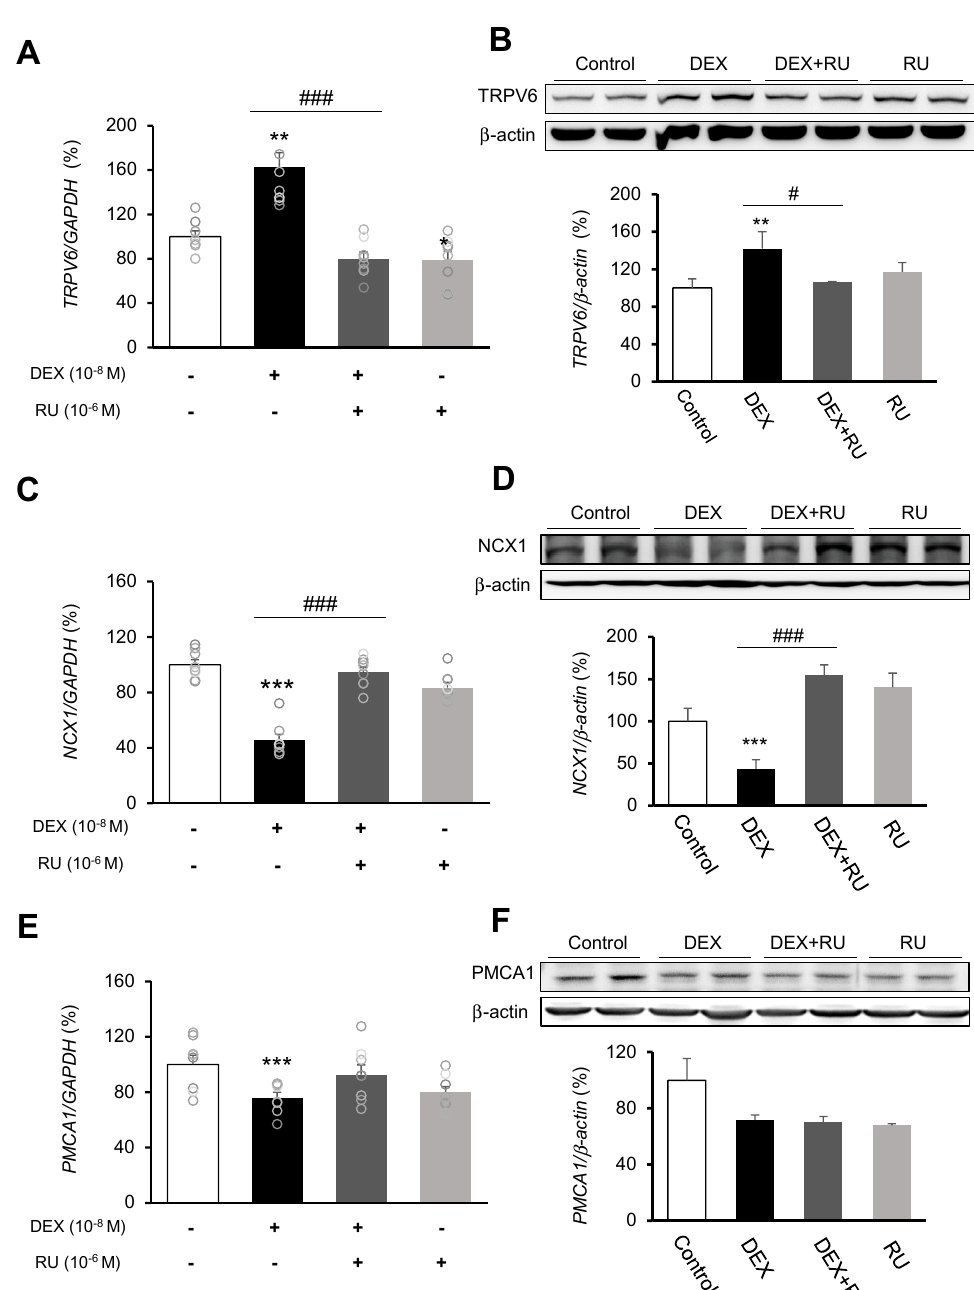
Figure 3. Regulation of calcium-processing gene expression by dexamethasone in A549 cells. Effect of DEX and its antagonist (RU486) on a transcriptional level of ( A ) transient receptor potential cation channel subfamily V member 6 (TRPV6) by real-time PCR, ( B ) TRPV6 by Western blotting, ( C ) sodium-calcium exchanger (NCX1) by real-time PCR, ( D ) NCX1 by Western blotting, ( E ) plasma membrane calcium ATPase 1 (PMCA1) by real-time PCR, and ( F ) PMCA1 by Western blotting. The mRNA level was measured by performing real-time PCR and was normalized by GAPDH. Quantification of protein levels determined by using NIH ImageJ software. Protein level was normalized by β -actin. * p < 0.05 versus Control; ** p < 0.01 versus Control; *** p < 0.001 versus control; # p < 0.05 versus DEX; ## p < 0.01 versus DEX; ### p < 0.001 versus DEX.